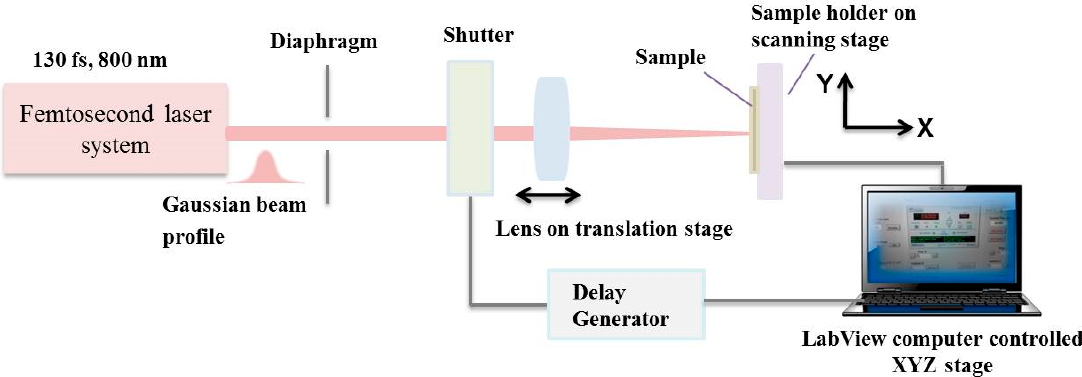
Figure 1. Optical setup for femtosecond laser modification of composite biomaterial structures.